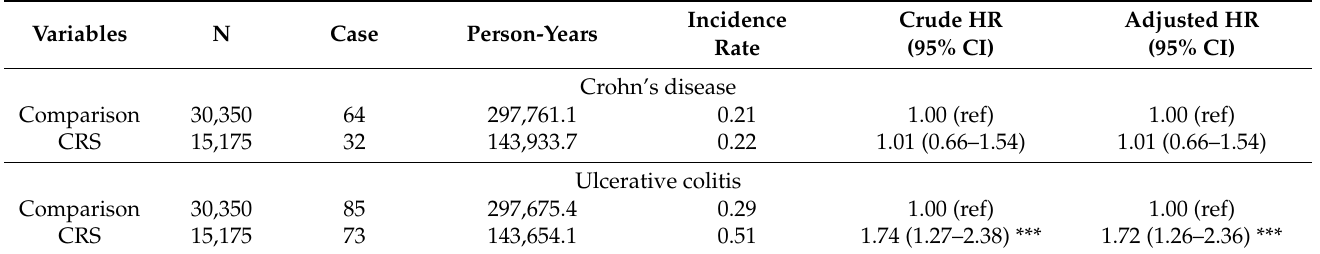
Table 2. The incidence rate (1000 person-years) and HR (95% CI) of incident inflammatory bowel diseases such as Crohn’s disease and ulcerative colitis associated with patients with CRS.